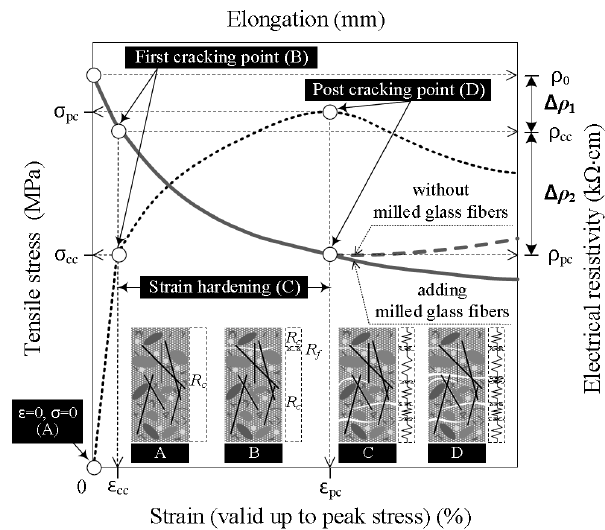
Figure 1. Typical electromechanical response of high-performance fiber-reinforced cementitious composites (HPFRCCs) under tension.